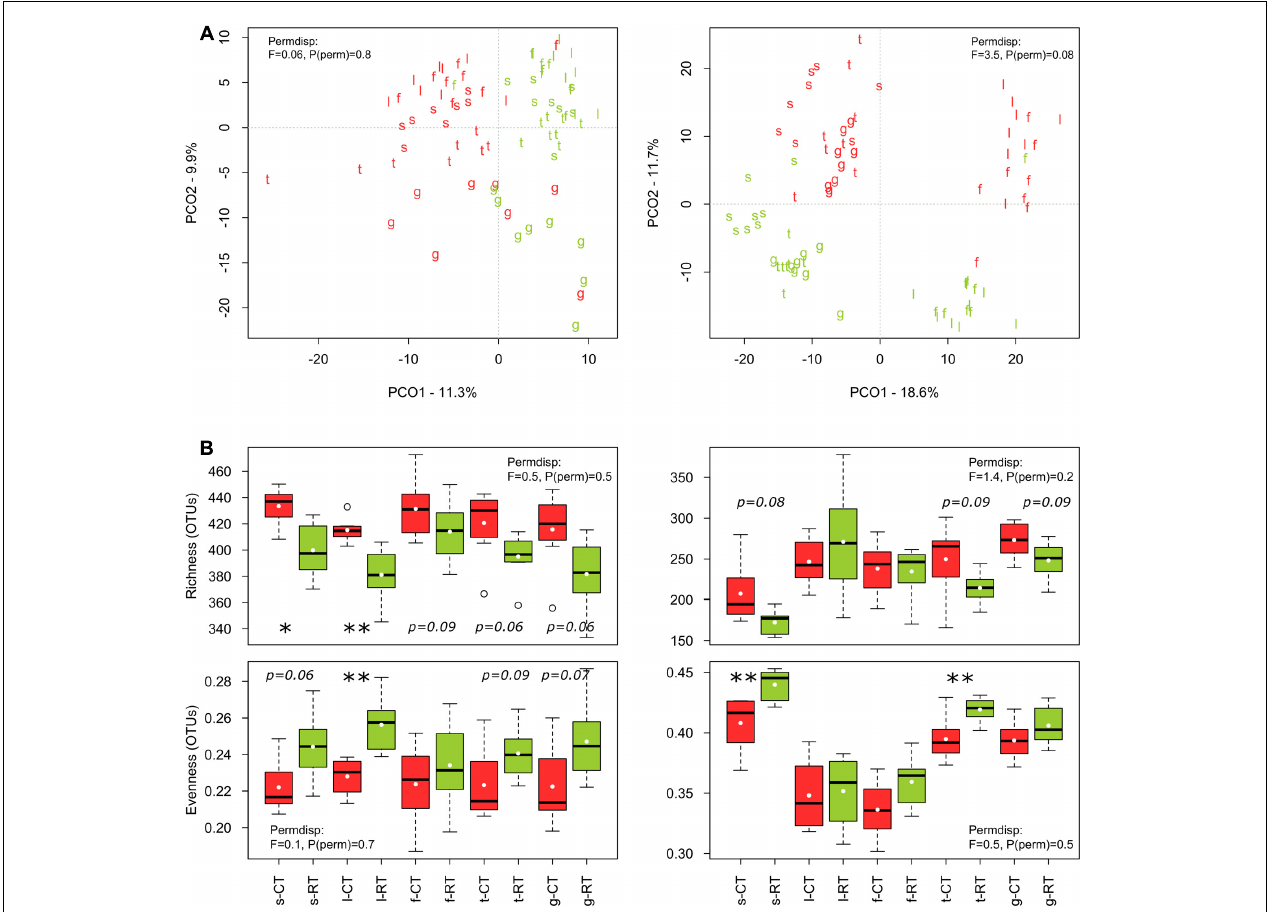
FIGURE 1 | Effects of tillage regime and growing season on bacterial and fungal β - (A) and α -diversity (B) . The principal coordinate analyses (PCO) ordination axes PCO1 and PCO2 represent 11 and 10% of the bacterial community variation, respectively, and 19 and 12% of the fungal community variation, respectively. Tillage regime is represented by color code with CT = red and RT = green and growing season is represented by letters with s = seedling, l = leaf development, f = flowering, t = tillering, g = grain filling. s , l, and f correspond to early, intermediate and late stage of V. faba , and t and g correspond to early and late stage of T. aestivum . Test statistics for assessing the heterogeneity of variance for tillage effect as assessed by PERMDISP are provied in the plots. The significant changes are labeled by asterisks: ∗ p < 0.05, ∗∗ p < 0.01, ∗∗∗ p <